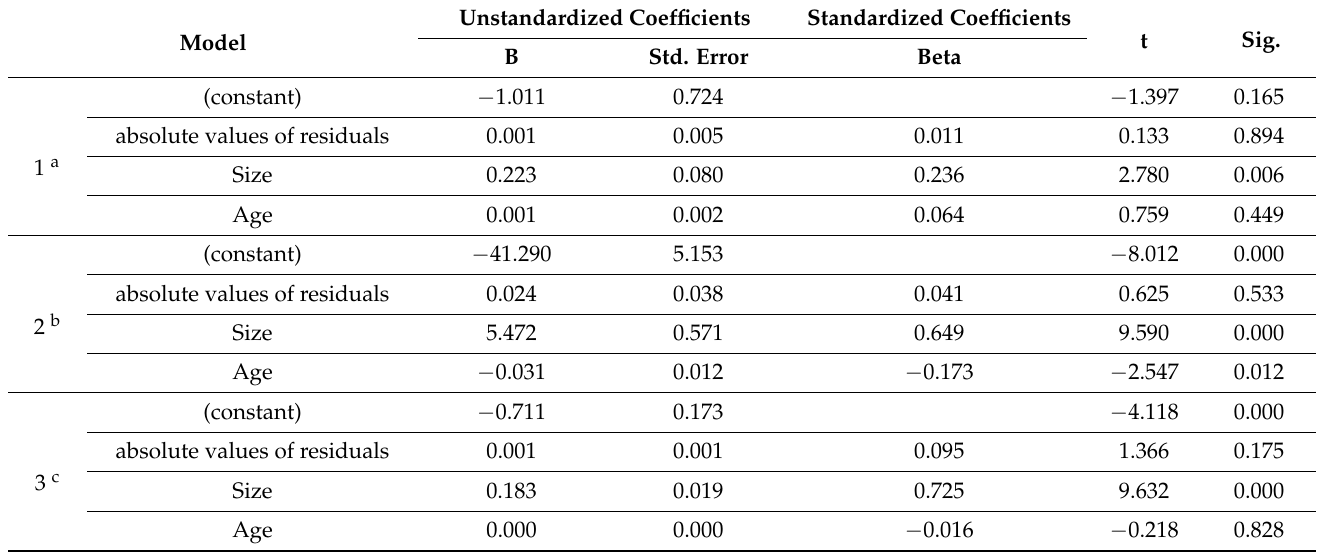
Table 11. Results of regressions between absolute values of residuals and banks’